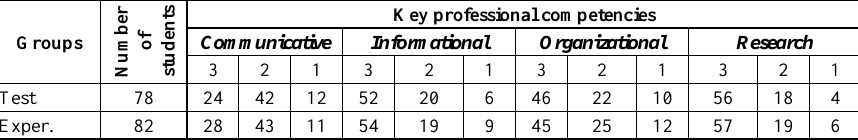
Table 2. Levels of professional competencies’ formation before the experiment Groups